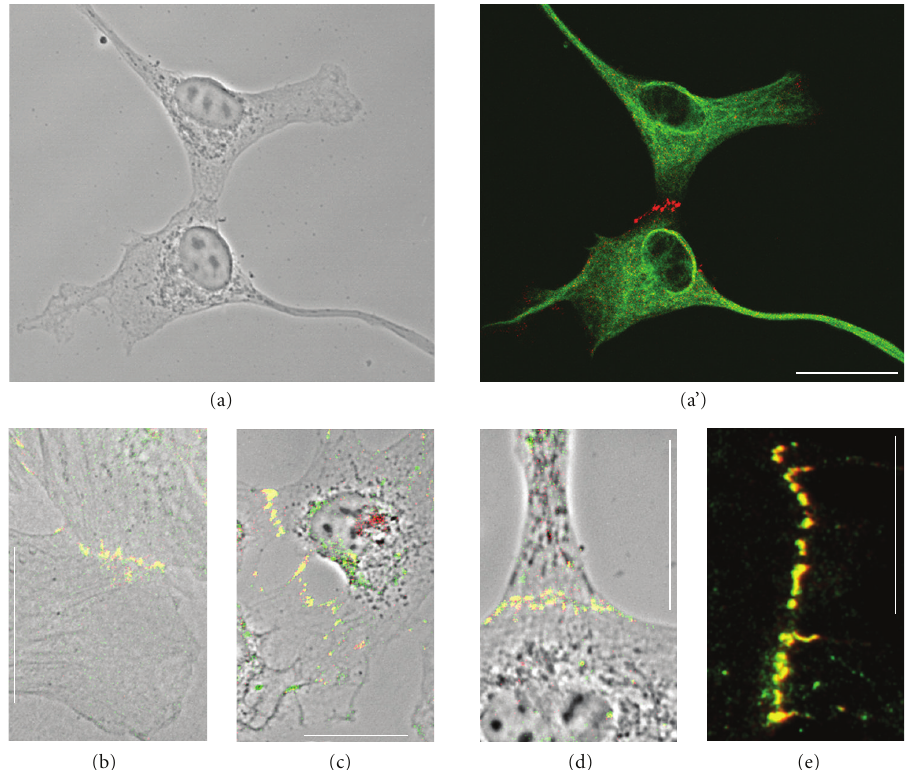
Figure 6: Double-label immunofluorescence micrographs, showing the localization of the “desmosomal protein”, plakophilin-2, in mesenchymally derived cultures of valvular interstitial cells (VICs). (a), (a (cid:2) ) Phase contrast and immunofluorescence micrograph showing ovine VICs forming clusters of AJs positive for the typical desmosomal plaque component plakophilin-2 (red; vimentin filaments are labeled in green). (b)–(d) Represent merged images of ovine VICs, showing colocalization staining (yellow) of plakophilin-2 (red) with typical AJ proteins such as cadherin-11 (green, (b)), β -catenin (green, (c)), protein p120 (green, (d)) all on a phase contrast background. (e) Human VICs exhibit similar colocalization of plakophilin-2 (red) here with N-cadherin (green) as shown by the yellow merge colour (for further details see [23]). Bar in (a): 25 μ m; bar in (b): 30 μ m; bars in (c) and (d): 20 μ m; bar in E: 10 μ